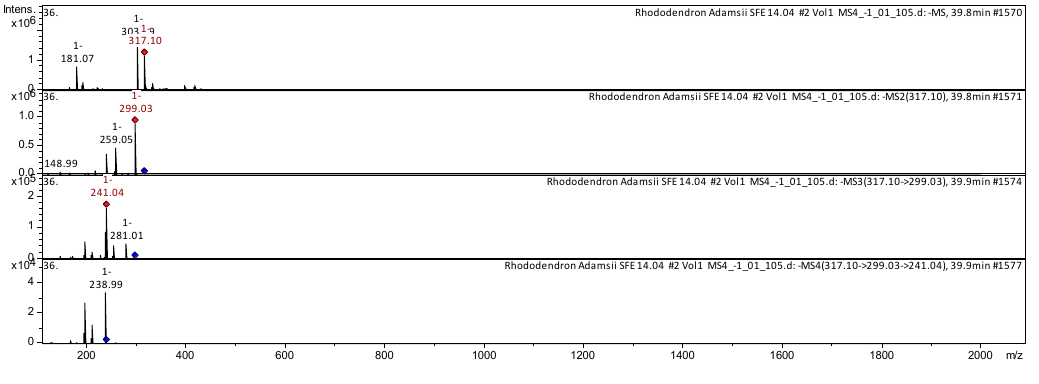
Figure 8. CID spectrum of myricetin from Rh. adamsii , m/z 317.10.